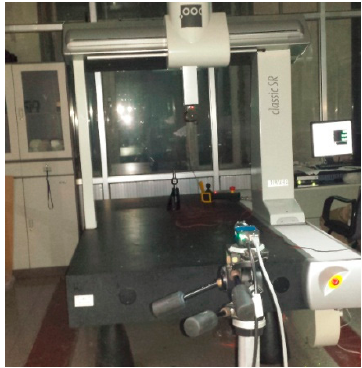
Figure 8. Photograph of the physical experiment. Table 1. DLT results of the physical experiment.